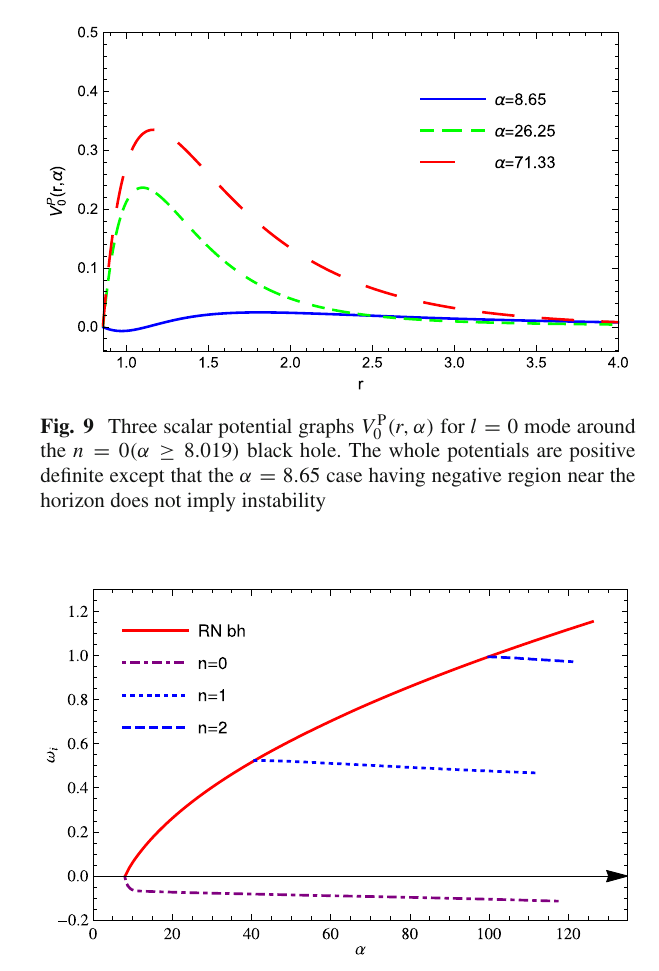
Fig. 10 The negative imaginary frequency ω i ( ω r = 0) as function of α appears for the l = 0 scalar around the n = 0 black hole, imply- ing the stability. Two positive imaginary frequencies ω i ( ω r = 0) are as functions of α for the l = 0 scalar around the n = 1 , 2 black holes, indicating the instability. A red solid curve with q = 0 . 7 rep- resents the quasinormal frequency of l = 0 scalar mode as function of α around the RN black hole [2], showing the unstable RN black holes for α > 8 .